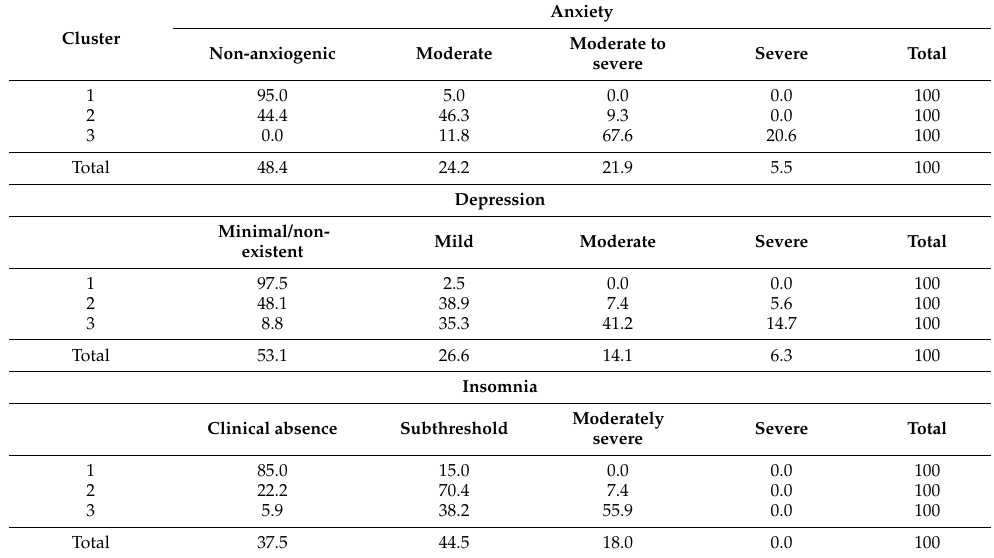
Table 12. Characterization of the segments according to anxiety, depression, and insomnia. Percentages.